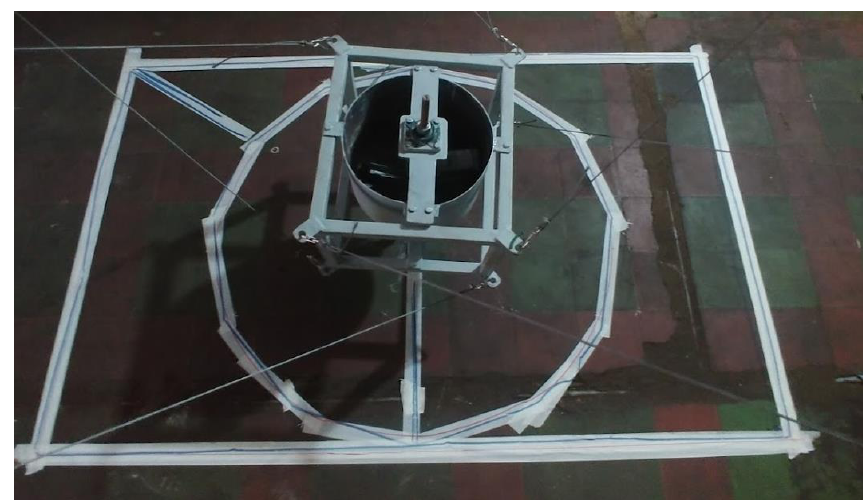
Figure 22. Experiment of the position error during linear interpolation.